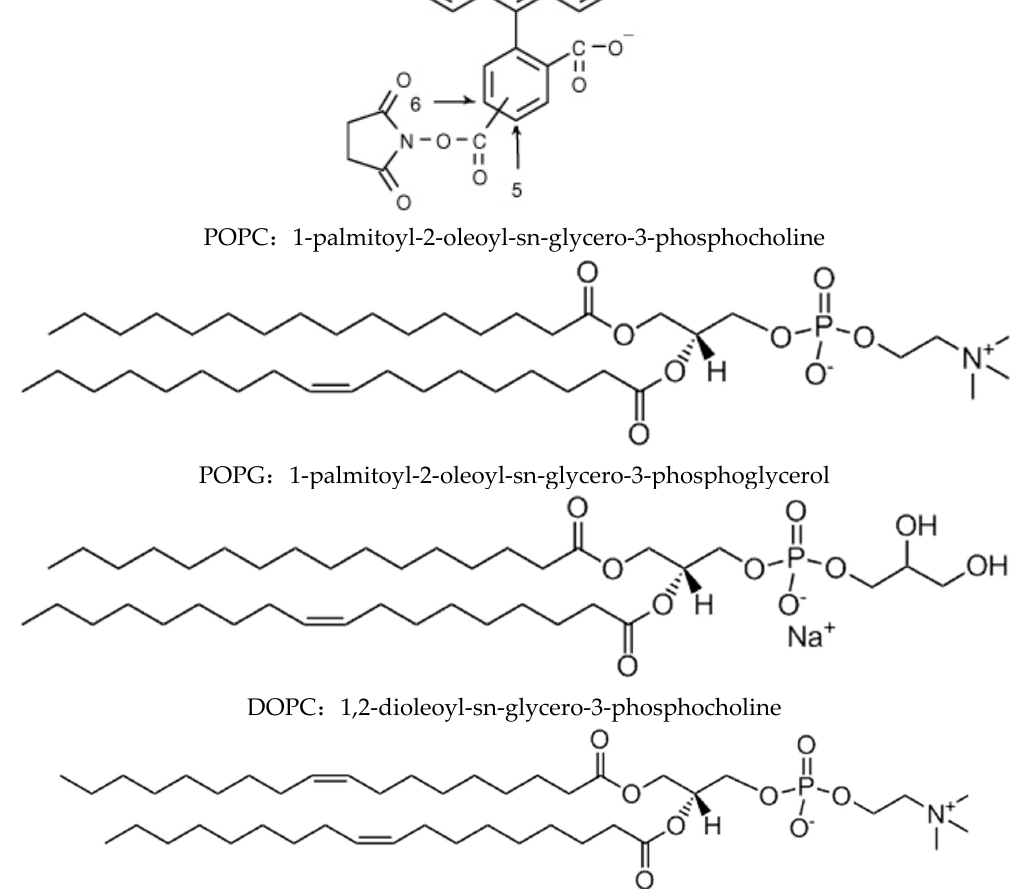
Figure 1. Molecular structures of both TAMRA and different types of lipids used in our experiments.